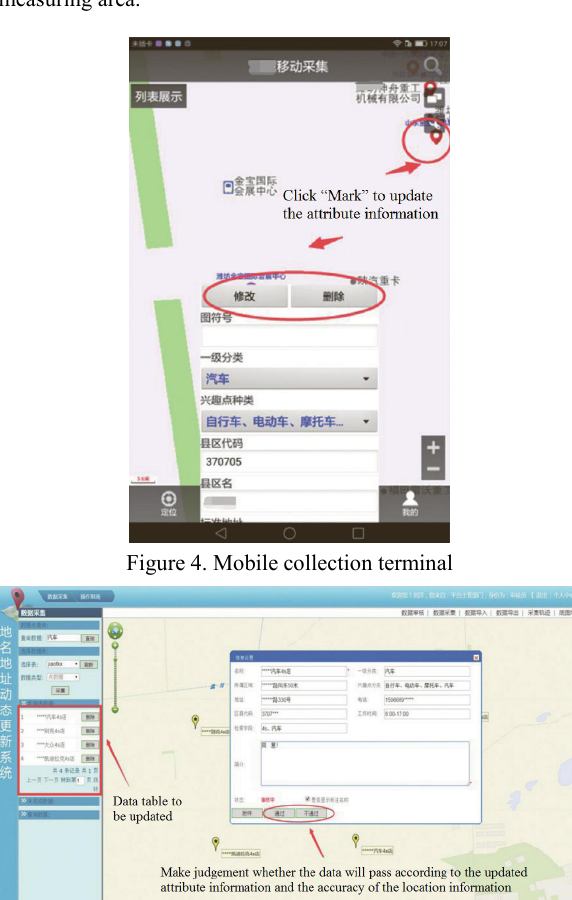
Figure 5. Reviewing information on the PC management